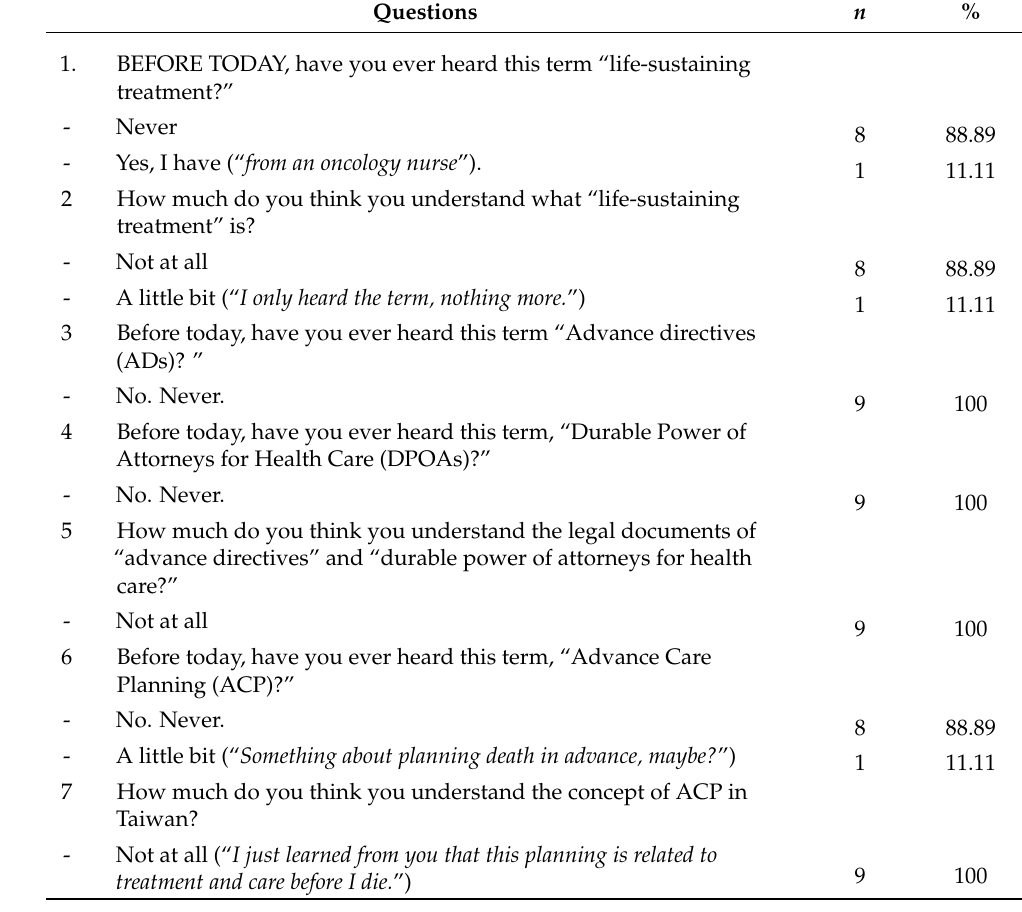
Table 2. Advance care planning awareness of the sample ( n =